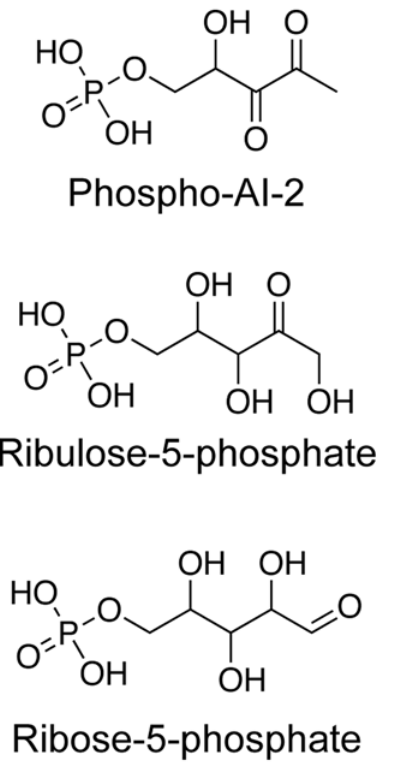
Figure1.Structuresofphospho-AI-2andtwoanalogues,ribulose- 5-phosphate and ribose-5-phosphate.